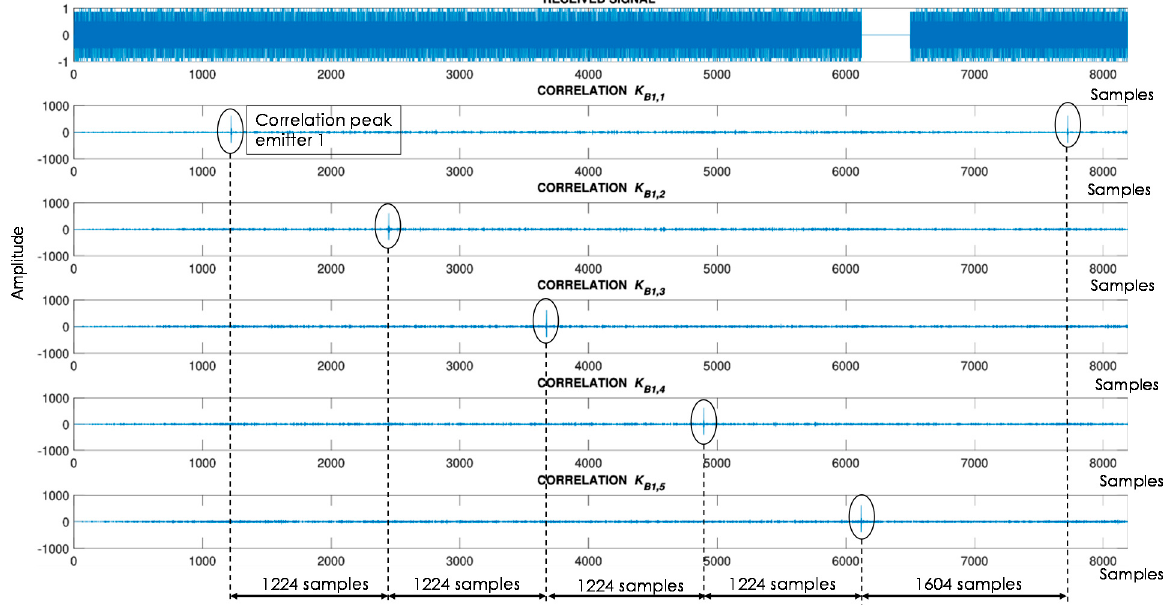
Figure 8. Example of correlation functions for U-LPS 1 when the receiver’s position is equidistant to all emitters (TDOA = 0).